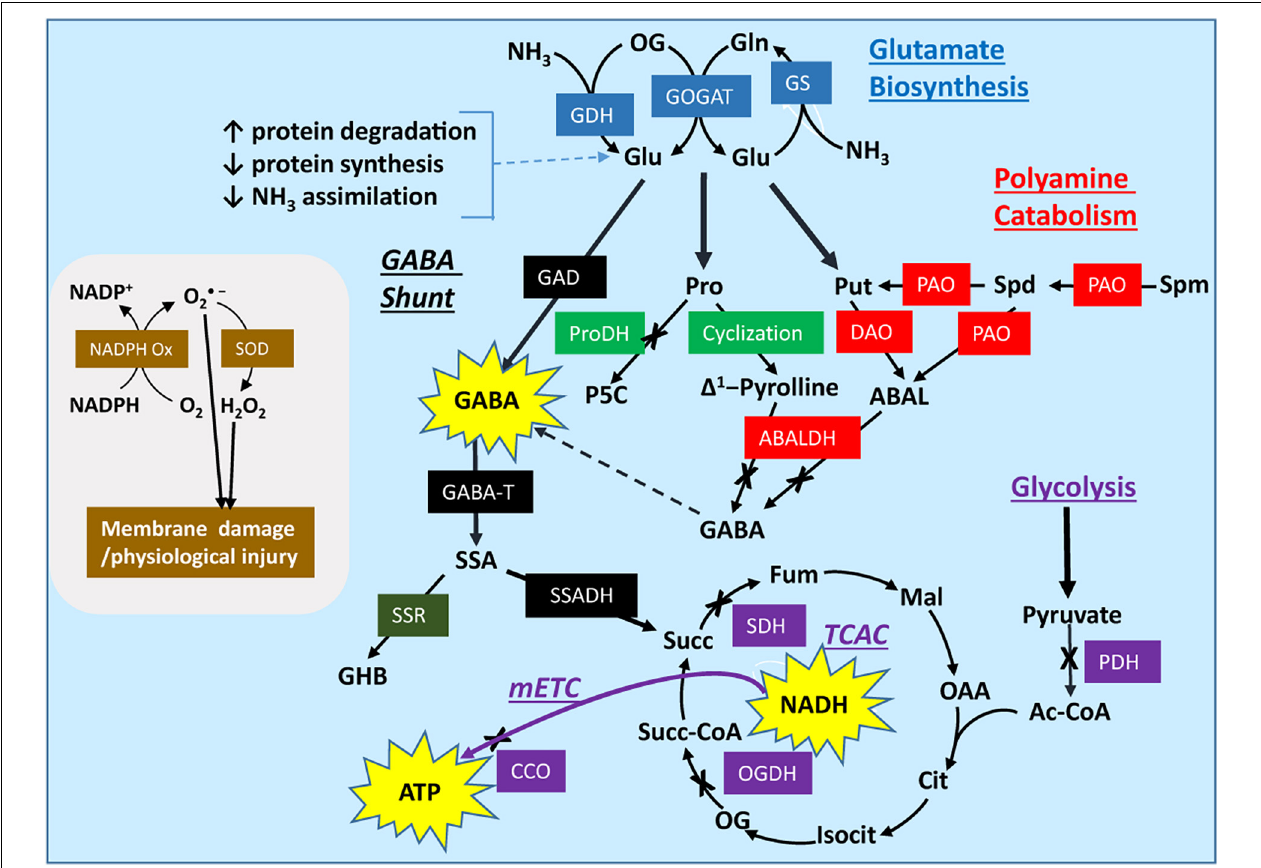
FIGURE 1 | Modeling the postharvest impact of low temperature and controlled atmosphere conditions on activities of the GABA shunt, polyamine catabolism, proline catabolism, respiratory processes, and oxidant systems in horticultural commodities. Low temperature, low O 2 and elevated CO 2 can limit the activities of pyruvate dehydrogenase, 2-oxoglutarate dehydrogenase, succinate dehydrogenase, and cytochrome c oxidase, leading to less NADH, FADH and ATP generation and more protein turnover. This is accompanied by a shift in redox balance. The elevated NADPH/NADP + ratio stimulates H 2 O 2 production via NADPH oxidase and superoxide dismutase, and stimulates the expression/activities of non-enzymatic and enzymatic antioxidants (not shown). Under these conditions, the availability of Glu and the synthesis of polyamines, proline and GABA increase. Polyamines often accumulate, but evidence suggests that only about 3% of the stress-induced GABA is derived from putrescine or spermidine catabolism, which may be explained, at least in part, by O 2 and NAD + limitation of DAO, PAO, and ABALDH activities. Proline also accumulates, in part due to the decline in proline dehydrogenase activity, but there is no direct evidence for the conversion of proline into GABA via ABALDH (because 4-aminobutanal and (cid:52) 1 -pyrroline are in rapid non-enzymatic equilibrium, their oxidation is often considered to be catalyzed by ABALDH). The limiting activities are to some extent overcome by H + stimulation or Ca 2 + /calmodulin activation of glutamate decarboxylase, which increases the biosynthesis of GABA and the carbon flux through succinic semialdehyde to succinate via GABA transaminase and succinic semialdehyde dehydrogenase, respectively. Only a minor portion of the NADPH is recycled via the diversion of succinic semialdehyde into γ -hydroxybutyrate. Consequently, stress-derived succinate stimulates the production of NADH and ATP via the non-cyclic tricarboxylic acid cycle and the mitochondrial electron transport chain. A representative oxidant system is shown on the left; it involves NADPH oxidase and superoxide dismutase, and contributes to membrane damage and physiological injury [Please refer to Shelp et al. (2021) for more detailed graphical representations]. Symbols: ↑ , increase; ↓ , decrease; colored rectangles, enzymes; X, biochemical reaction potentially inhibited by stress; thick arrows, multiple biochemical steps; moderately thick arrows, the GABA shunt. ABAL, 4-aminobutanal; ABALDH, 4-aminobutanal dehydrogenase;